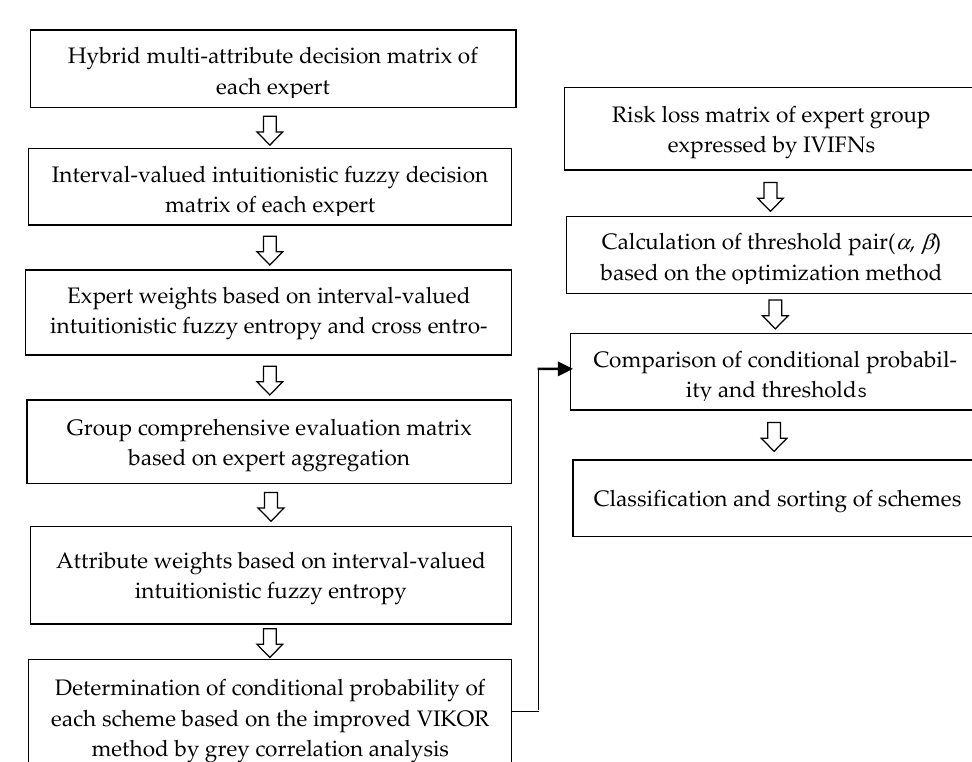
Figure 1. The steps of hybrid multi-attribute three-way group decision making.